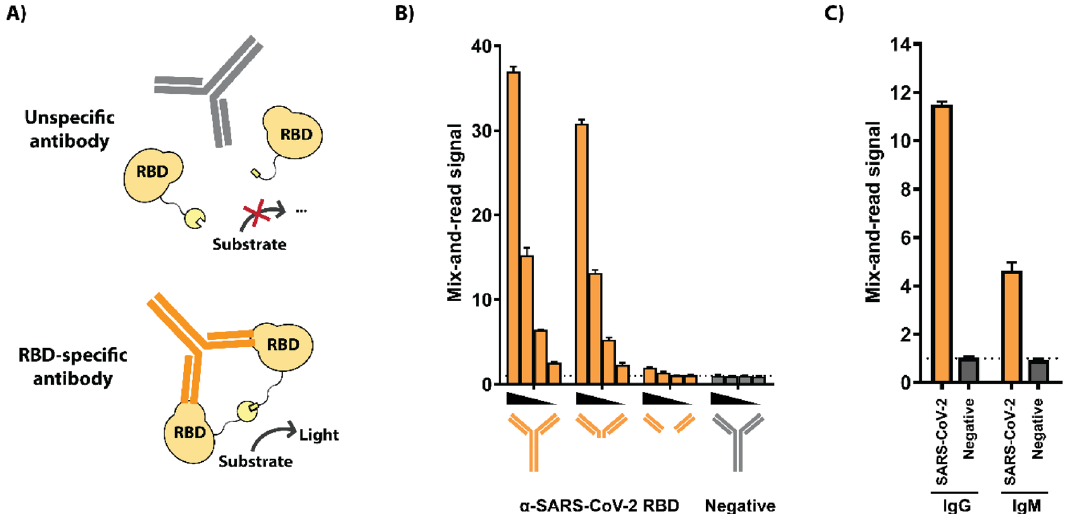
Figure 1. Assay principle. ( A ) Schematic. Small and large fragments of the NanoBit split luciferase are tethered to SARS-CoV-2 receptor-binding domains (RBD) via peptide linkers. When a specific antibody binds 2 RBD antigens, it forces the luciferase halves into proximity with each other, thereby activating the enzyme. Signal is quantified from a homogeneous assay setup after adding luciferase substrate. ( B ) Demonstration of assay principle. Dose-responsive assay activation by an RBD-specific monoclonal antibody or corresponding F(ab ′ ) 2 or Fab fragments (orange) or control antibody (gray). ( C ) Activation by specific IgG and IgM antibodies. Human IgG and IgM fractions were purified from a SARS-CoV-2 specific serum pool or a negative control pool and tested for activity in the assay. ( B ) and ( C ): technical triplicates with averages and standard deviations